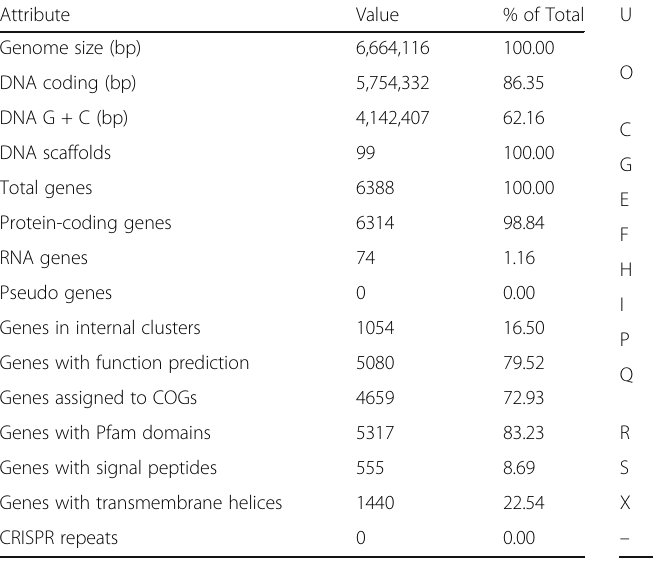
Table 3 Genome statistics for Ensifer meliloti Mlalz-1